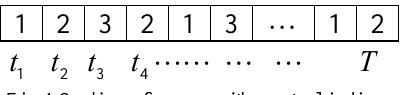
Fig.4 Coding of genes with control indices